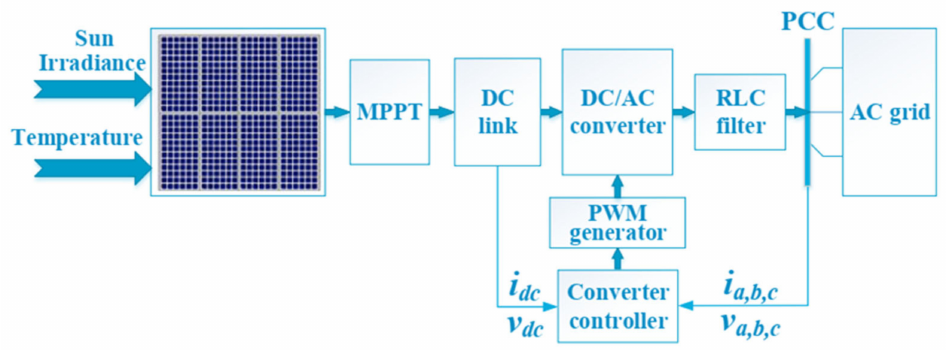
Figure 11. Example of a photovoltaic power generator path (transformer free)